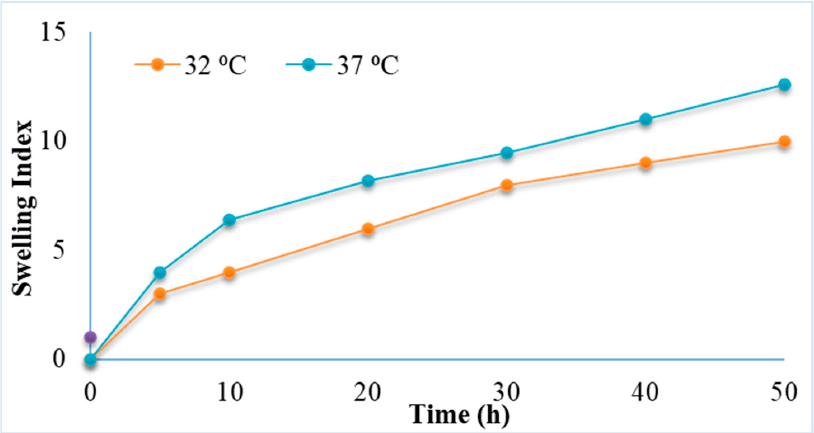
Figure 5. Swelling index of 5FU-Alg-Np-HG at 32 and 37